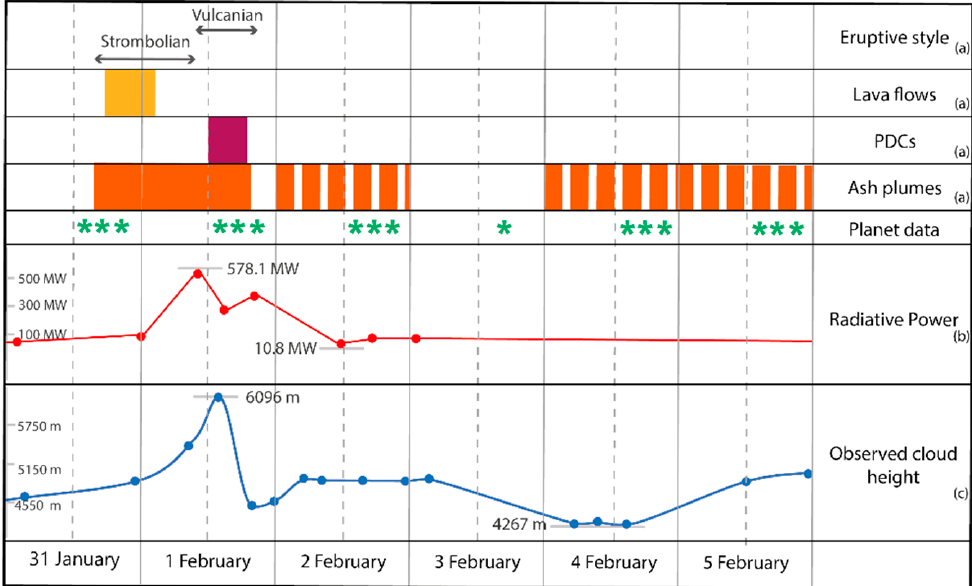
Figure 2. Timeline of the February 2018 eruption of Fuego and its main physical and volcanological features. Data sources: ( a ) Smithsonian Institution Global Volcanism Program (GVP) [24]; Planet Labs data coverage [26]; ( b ) MODVOLC website [36]; ( c ) VAAC database [37]. Planet labs imagery timeline is in Table S1.